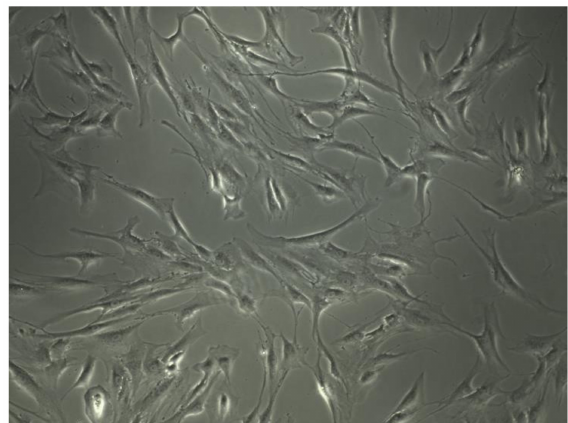
Figure 3. Human mesenchymal stem cells morphology under 10 × optic microscopy.